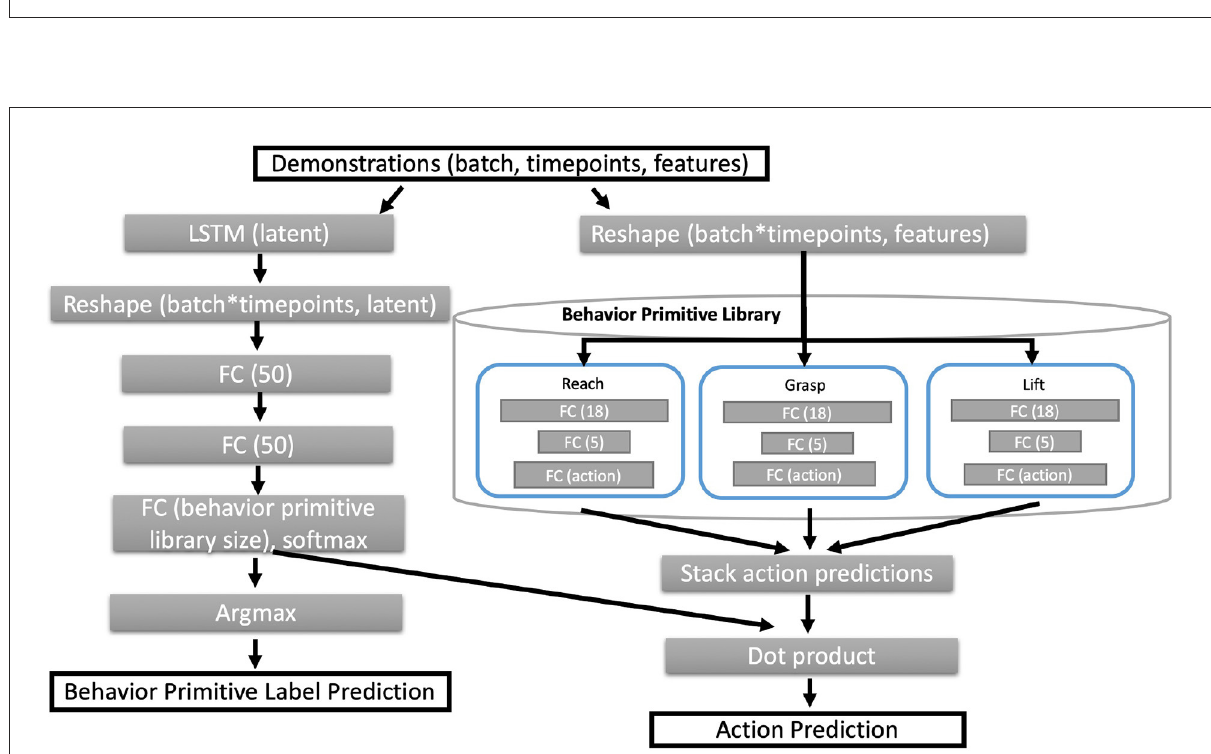
FIGURE3 Hierarchical recurrent deep network architecture for task decomposition, novel behavior primitive discovery, and behavior blending.